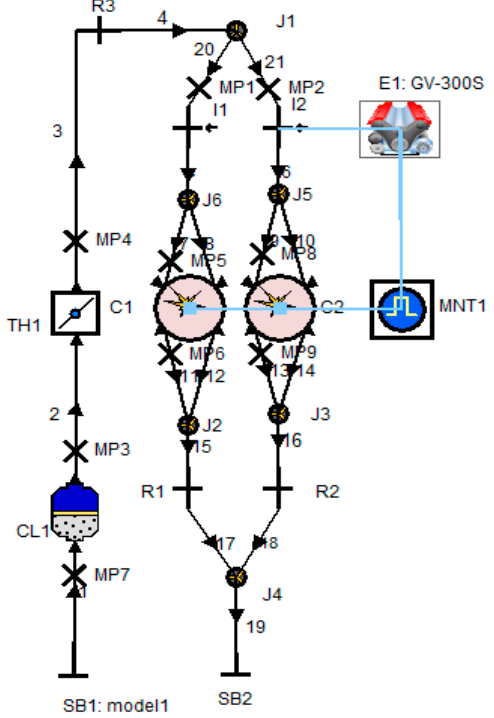
Figure 3. GV-300S simulation engine model.